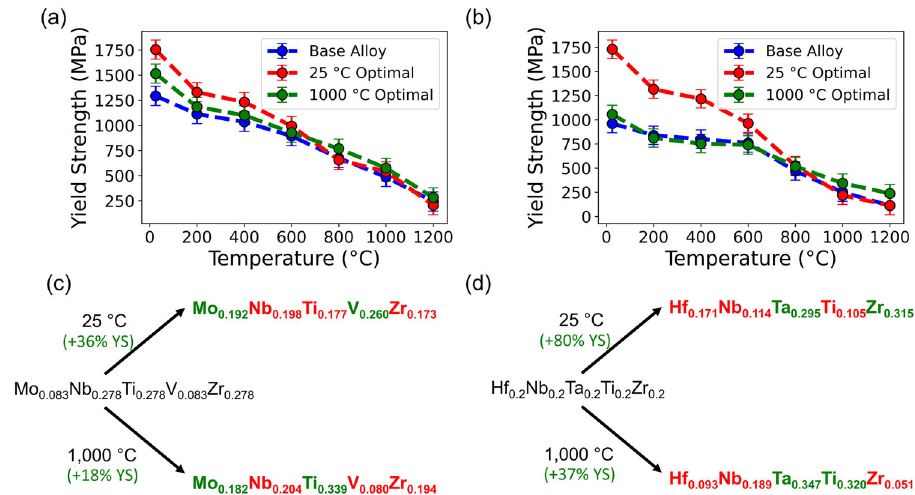
Fig. 5 Composition optimization of known alloys to improve yield strength at 25 °C and 1000 °C. a Mo 0.3 NbTiV 0.3 Zr base alloy case, and the ( b ) HfNbTaTiZr base alloy case. The original base alloy is shown together with the optimized alloy for 25 °C and the optimized alloy for 1000 °C. The element compositions corresponding to each case are shown in panels ( c ) and ( d ). Element fractions that were increased during the optimization are shown in green text, while element fractions that were decreased are shown in red text. A 95% con fi dence level error (± 94 MPa) is shown for